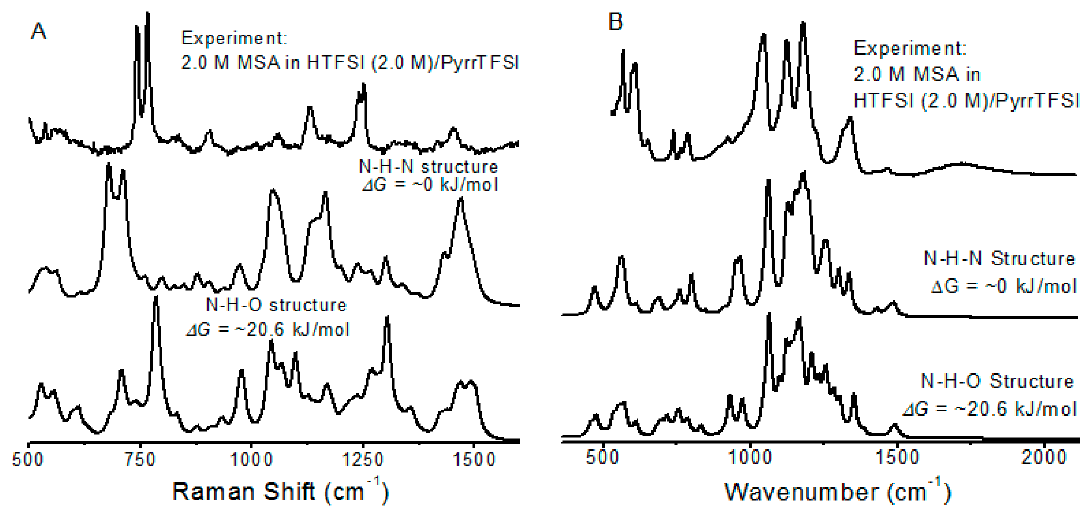
Figure 9. The experimental Raman spectrum ( A ) and IR spectrum ( B ) are compared to simulated Raman spectra ( A ) and simulated IR spectra ( B ) for the N-H-N “bridged” structure from Figure 8A and the N-H-O “bridged” structure from Figure 8B. In both panels A and B, the top trace is the experimental result and the bottom two traces are simulations.